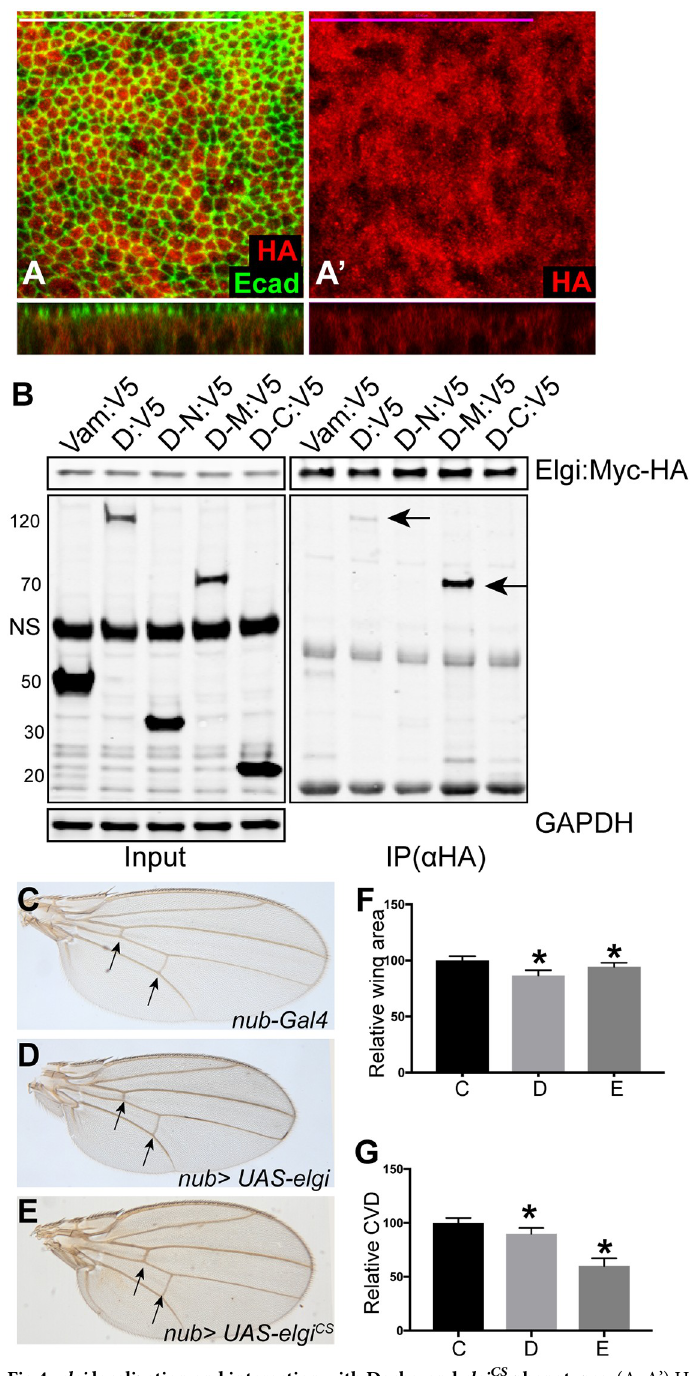
Fig 4. elgi localization and interaction with Dachs, and elgi CS phenotypes. (A, A’) Horizontal apical sections (above) and vertical sections (below) of wing imaginal discs expressing nub-Gal4 UAS-elgi-MYC-HA and stained with anti E- cad (green) and anti HA (red) antibodies showing diffuse cytoplasmic localization of Elgi. Scale bar is 33.0 μ m. (B) Western blot showing results of co-immunoprecipitation experiments on proteins co-expressed in S2 cells. V5-tagged Vam, Full length Dachs (D:V5), Dachs N terminus(D-N:V5), Dachs Middle domain (D-M:V5) or Dachs C terminus (D-C:V5) were co-expressed with full length Elgi-MYC-HA, and complexes were precipitated using Ezview red anti HA affinity resin and immunoblotted with Rabbit anti V5 and Rabbit anti HA antibodies. GAPDH was used as a control for loading and transfer in the input lanes. Arrows point to the co-immunoprecipitated bands. NS: non- specific (C-E) Adult male wings from flies expressing nub-Gal4 (control) (C), nub-Gal4 UAS-elgi (D) and